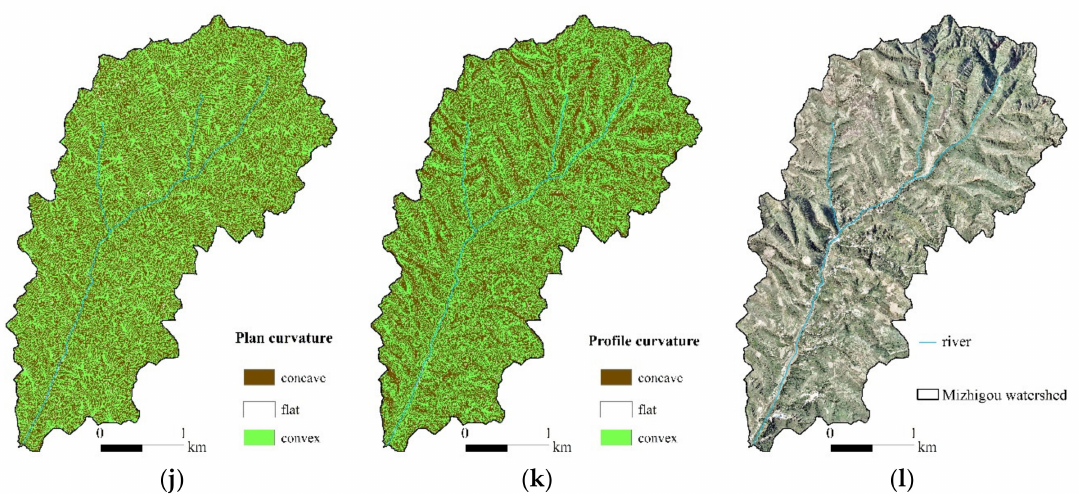
Figure 4. Gully erosion influencing factors. ( a ) Slope gradient. ( b ) Altitude. ( c ) FVC. ( d ) LS. ( e ) Land use. ( f ) Distance from stream. ( g ) TWI. ( h ) Contributing area. ( i ) Slope aspect. ( j ) Plan curvature. ( k ) Profile curvature. ( l )